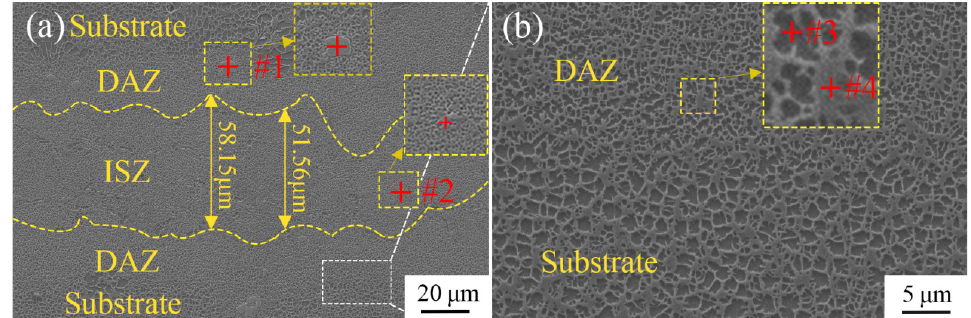
Figure 3. SEM images of cross-section of TLP-diffusion-bonded joint using low-B interlayer. ( a ) TLP joint bonded at 1250 °C for 6 h; ( b ) Expanded region in ( a ).